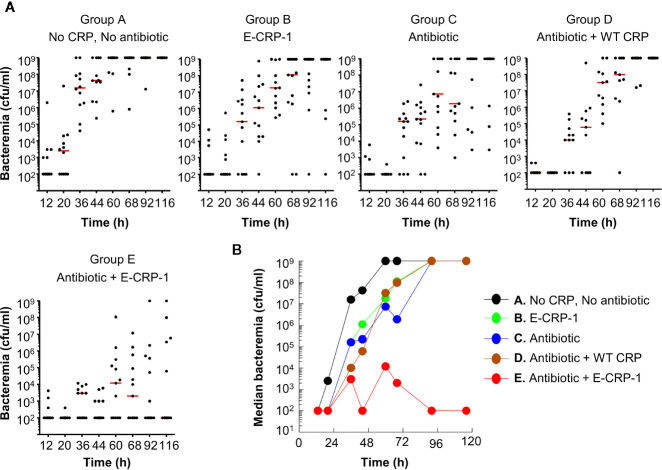
Bacteremia in mice infected with pneumococci and treated with E-CRP-1 and clarithromycin. Blood was collected from each surviving mouse shown in
Figure 2
. (A) Scatter plots of the bacteremia data. The horizontal red line in each group of mice represents median bacteremia. (B) The median bacteremia values, derived from (A) For 36–92 h, the p-value for the difference between groups A and B was <0.05. For 20–68 h, the p-value for the difference between groups A and C was <0.05. For all time points, the p-values for the differences between groups B C and C D were >0.05. For 36–116 h, the p-values for the differences between groups C E, B E, and D E were <0.05, with most significant difference (p < 0.005) between 44–92 h.